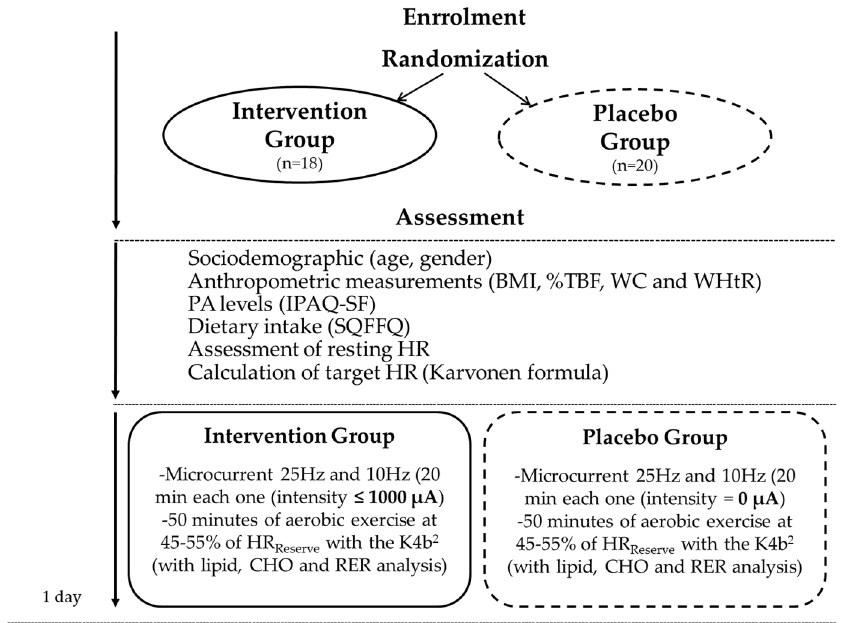
Figure 2. Overview of the procedures of the study. BMI, body mass index; %TBF, total body fat percentage; WC, waist circumference; WHtR, waist-to-height ratio; IPAQ-SF, short form of the international physical activity questionnaire; SQFFQ, Semi-quantitative Food Frequency Questionnaire; HR, heart rate; CHO, carbohydrate; RER, respiratory exchange ratio.